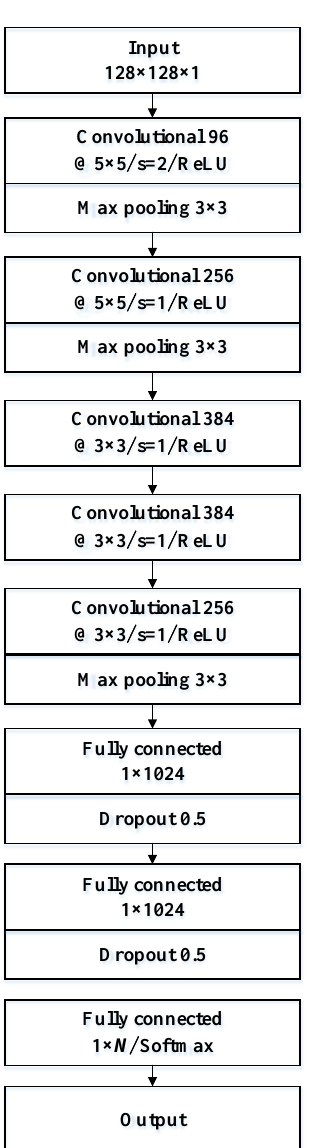
Figure 6. Flowchart of the target classification.